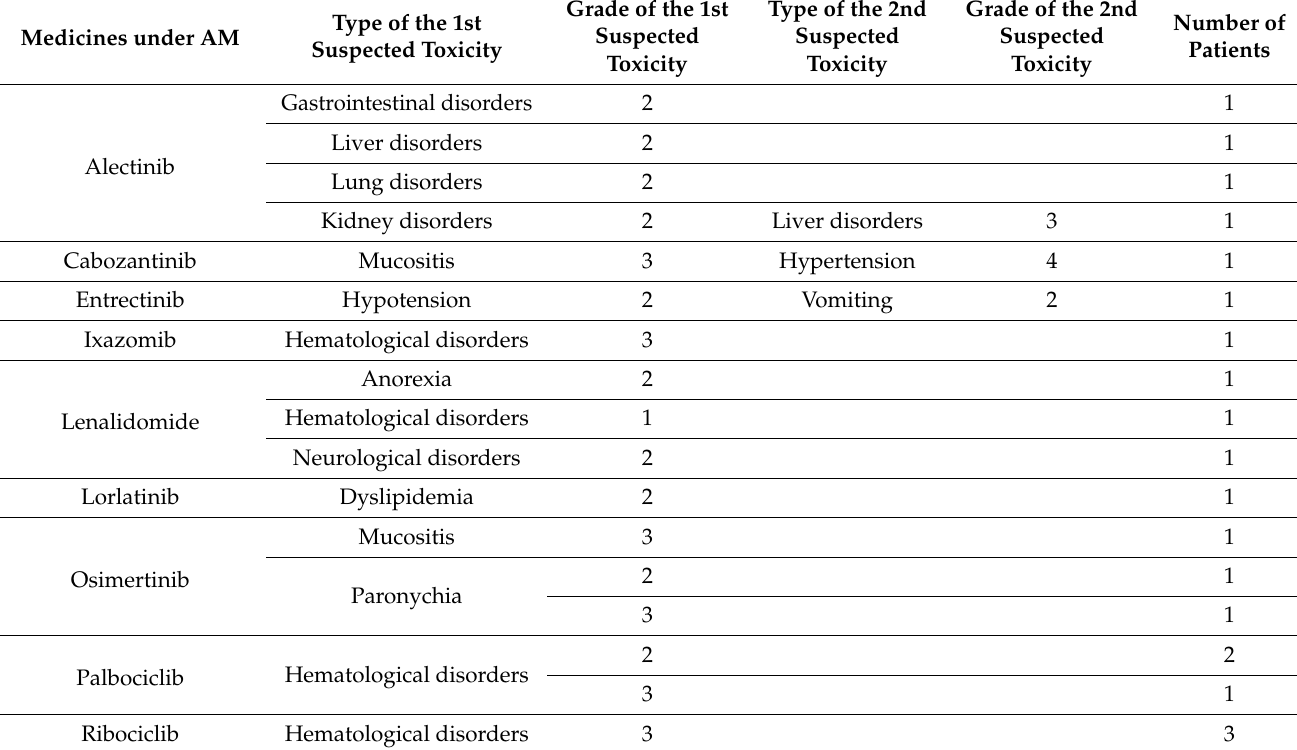
Table 4. Type and grade of suspected toxicity associated with the medicines in this